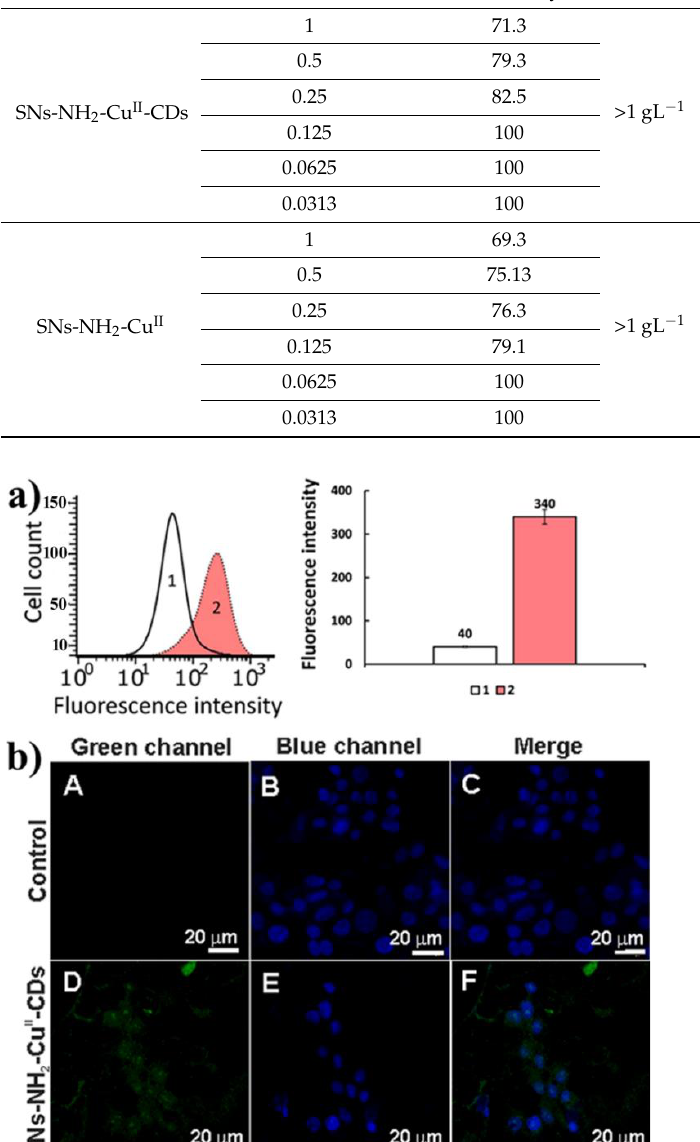
Table 2. The cell viability and IC 50 values of M-HeLa and Chang Liver cells in the presence of different concentrations of SNs-NH 2 -Cu II -CDs and SNs-NH 2 -Cu II . Compound Concentration, gL − 1